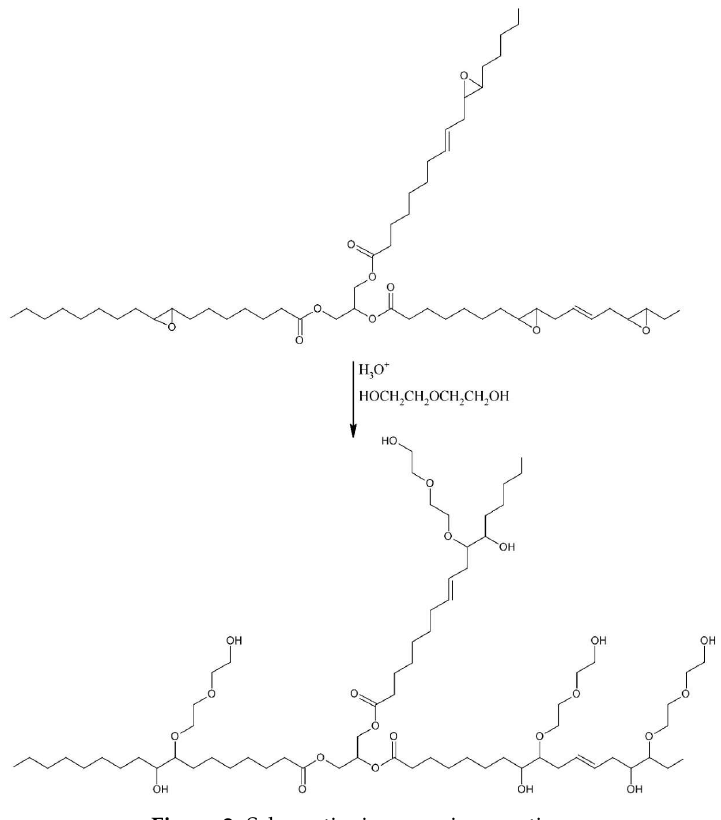
Figure 2. Schematic ring-opening reaction.